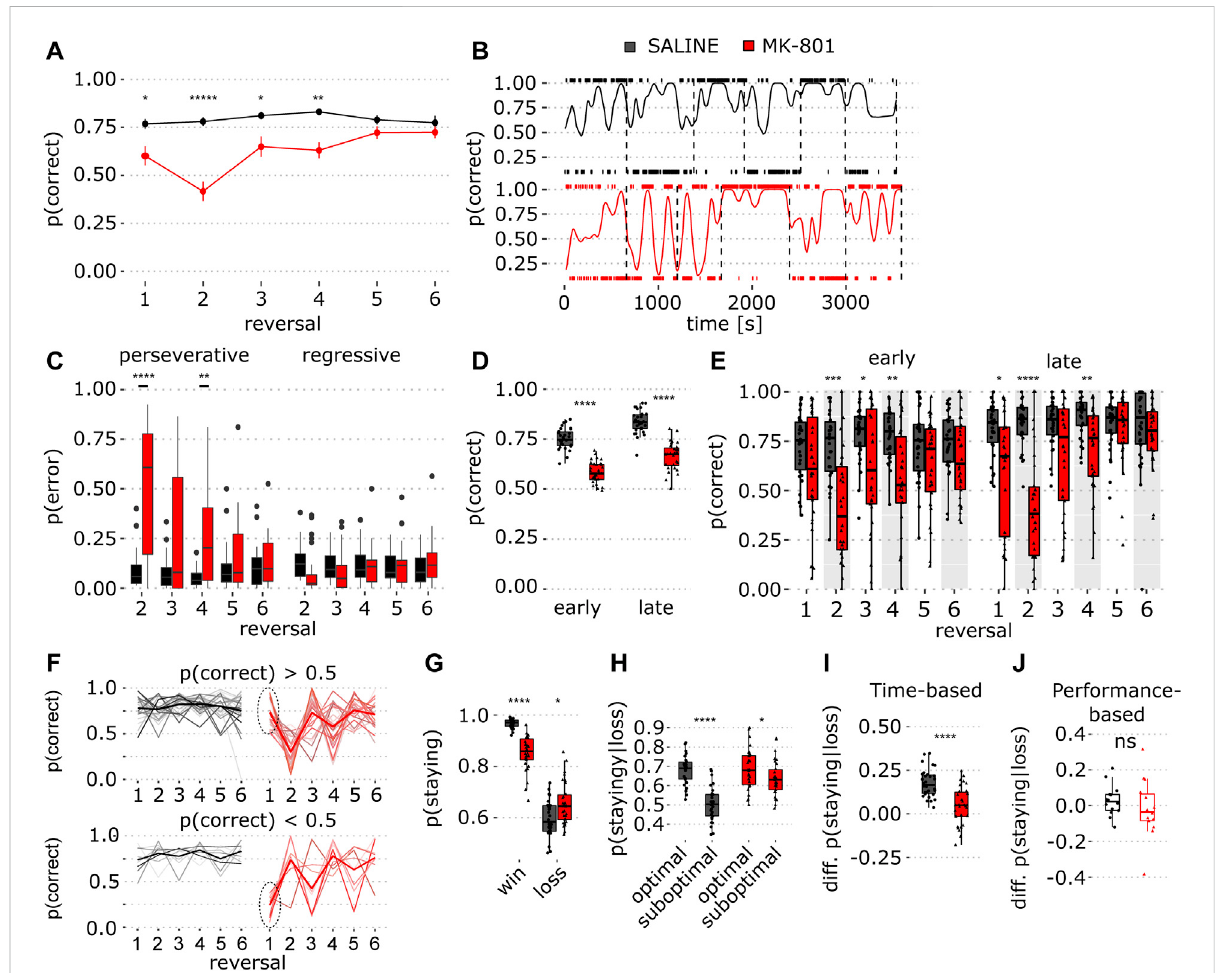
FIGURE 2 Sustained reversal de fi cit in time-based PRL in MK-801. (A) Proportion of correct responses in saline (black) and MK-801 (red) for individual reversal blocks. Data show mean ± SEM. Note the sustained effect of MK-801 in multiple reversals (red line, blocks 2-4) (for stats, see Table 1). (B) Single rat ’ s performance; trace shows a smoothed proportion of correct lever responses in saline (top) and MK-801 (below). Tick marks above and below each graph indicate right and left lever presses, respectively. Vertical dashed lines indicate reversals. (C) Proportion of perseverative and regressiveerrorsinreversalblocks2 – 6(forstats,seeTable1). (D) Earlyandlatetrialperformancemeasuredastheproportionofcorrectleverpresses collapsed over the whole session. (E) Same as in D, but for individual reversal blocks (for stats, see Table 1). (F) Proportion of correct responses